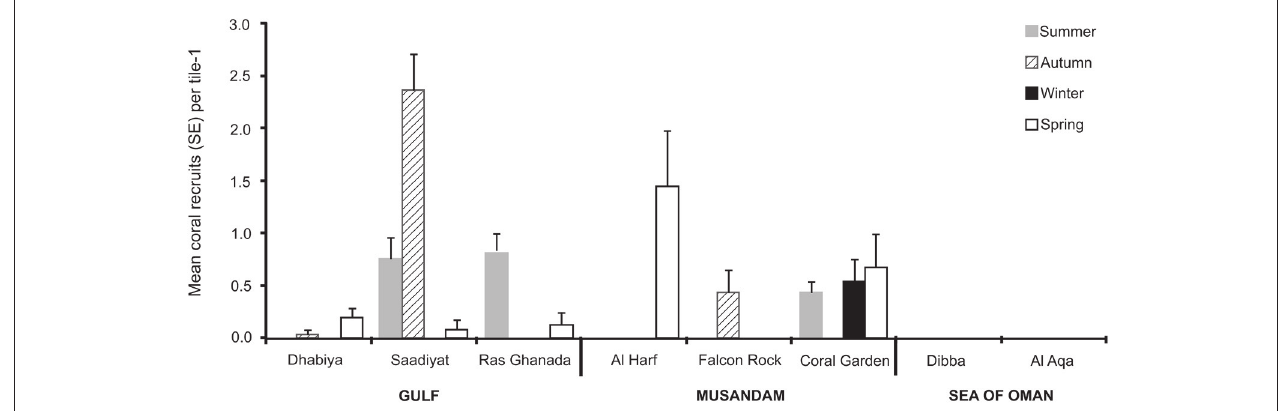
FIGURE 4 | Spatio-temporal variability in the density of coral spat (mean ± SE) on settlement tiles.